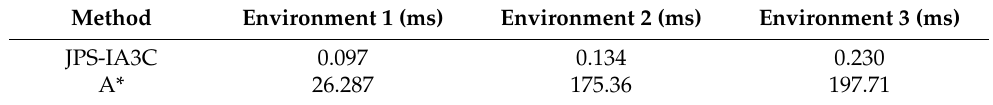
Table 4. First-Move Lag of A* and JPS-IA3C.